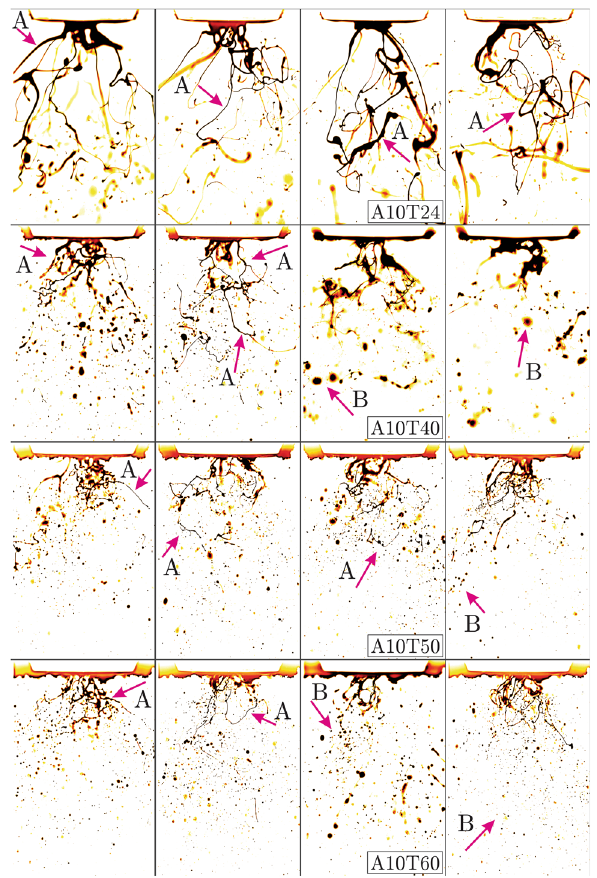
Figure 3. Bio-oil injected at the preheating temperatures T = 24, 40, 50, 60 ( ◦ C) ( T 24, T 40, T 50 and T 60), liquid flow rate of q f = 1.8 (kg/h) ( L 04 cases at 4 (lb/h)) and air flow rate q a = 10 (l/min) ( A 10 cases). (FOV: × 14.15 d 9.43 d a a